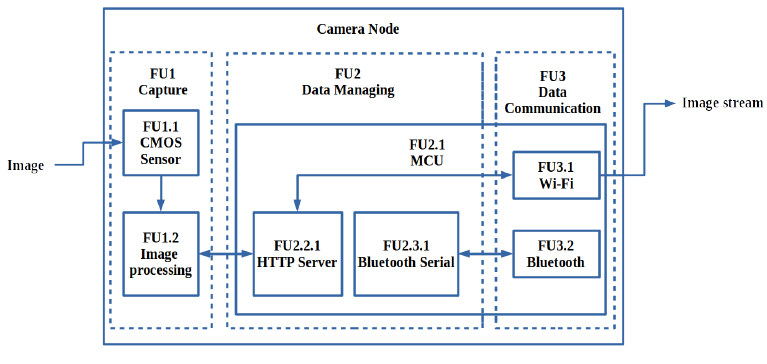
Figure 7. Functional diagram of the camera node, transferring the image stream over